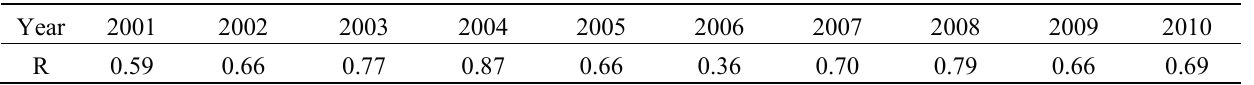
Figure 1. Comparison between the flux-tower GPP and MOD17A2 GPP from 2001 to 2010 (points represent mean  standard-error). Blue lines represents MODIS GPP, red lines represents EC GPP and the dashed lines are the dividing lines of the seasons: spring (DOY 65–152), summer (DOY 153–248), autumn (DOY 249–335) and winter (DOY 0–64 and 336–366). Table 1. Correlation coefficients (R) between 8-day means of MOD17A2 GPP and EC GPP from 2001 to